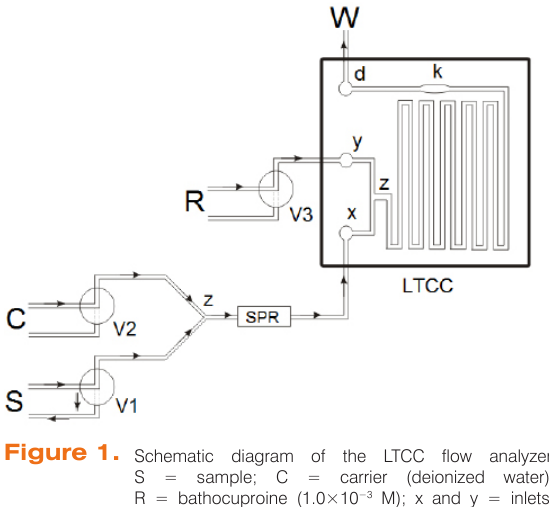
Figure 1. Schematic diagram of the LTCC flow analyzer. S = sample; C = carrier (deionized water); R = bathocuproine (1.0×10 −3 M); x and y = inlets; d = outlet; z = confluence point; k = optical path (0.5 mm); and W = waste; V1, V2, and V3 are solenoid valves;